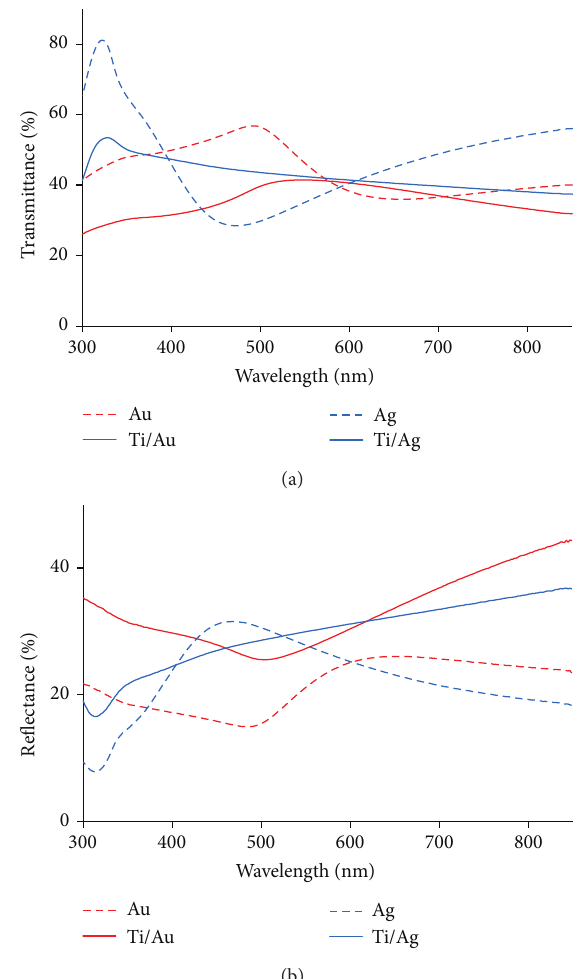
Figure 8: Transmittance (a) and reflectance (b) spectra of 8nm thick Au nanostructures with and without Ti on glass. The metal is deposited at 𝛼 = 70 ∘ (the samples were rotated during the